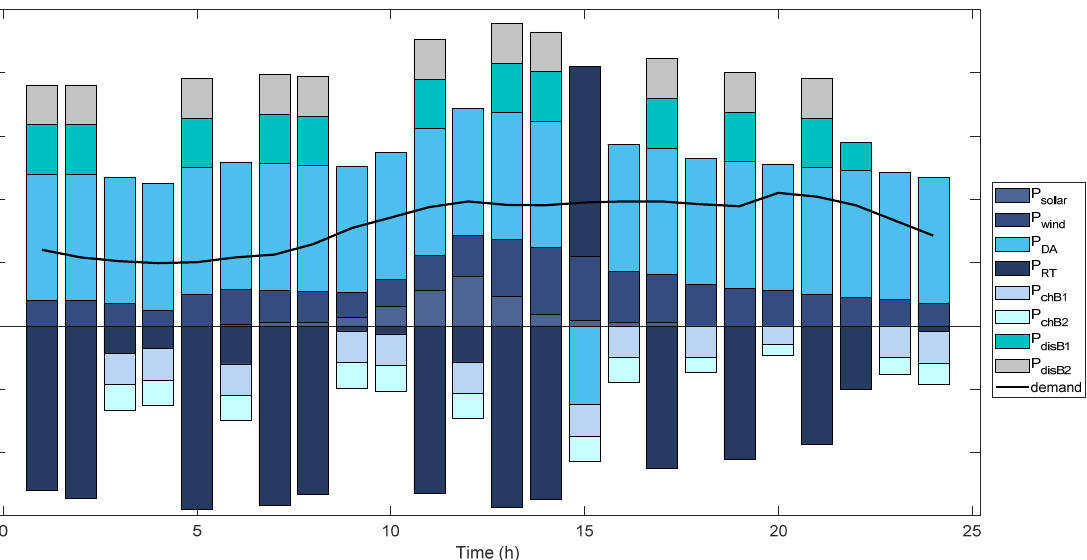
40 Table 2. Electrical system parameters of the test system. Taken from [32]. Parameter